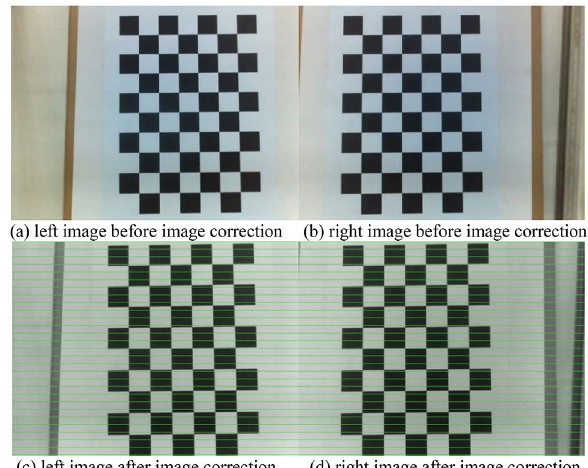
Figure 5. Image correction